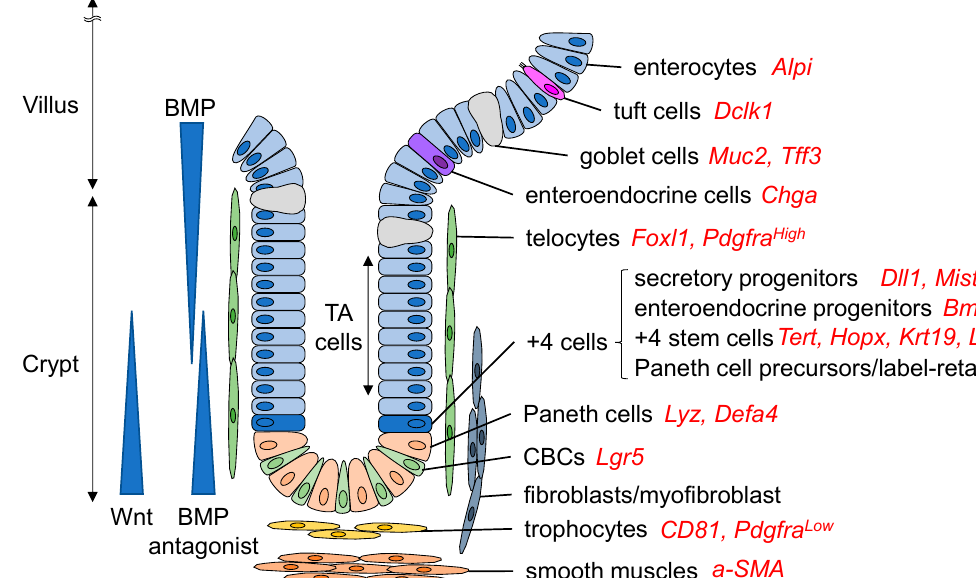
Figure 1. Intestinal stem cells and their niches. Lgr5+ crypt base columnar (CBC) cells reside at the crypt base and continuously supply their daughter cells from crypt to villi. Paneth cells, interspersed between Lgr5+ CBC cells, can act as a stem cell niche to maintain the stem cell functions of CBC cells. There is another stem cell pool, the +4 cells, which contain quiescent +4 stem cells, Paneth cell precursors, and label-retaining cells. Transit-amplifying (TA) cells include more differentiated and actively proliferating but relatively short-lived cell populations, including both secretory and absorptive progenitors, which can give rise to stem-like cells following stem cell damage. Secretory progenitors are differentiated into Paneth cells, goblet cells, tuft cells, and enteroendocrine cells, while absorptive progenitors enterocytes. The stromal cells surrounding the crypt region contribute to the stem cell niche and are classified into several subsets, such as fibroblasts, myofibroblasts, telocytes, and trophocytes, all of which express and secrete stem cell niche factors. Representative markers of each cell are shown in red.